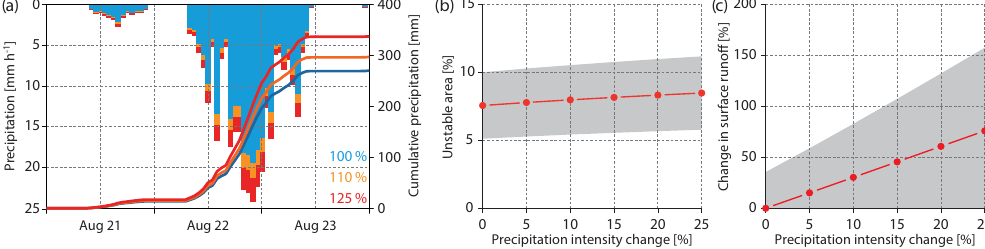
Figure 13. Scaled rainfall event of August 2005 (a) and resulting changes in slope stability (b) and surface run-off (c) , based on the ensemble runs with a scaled precipitation input. The area shaded in grey shows one standard